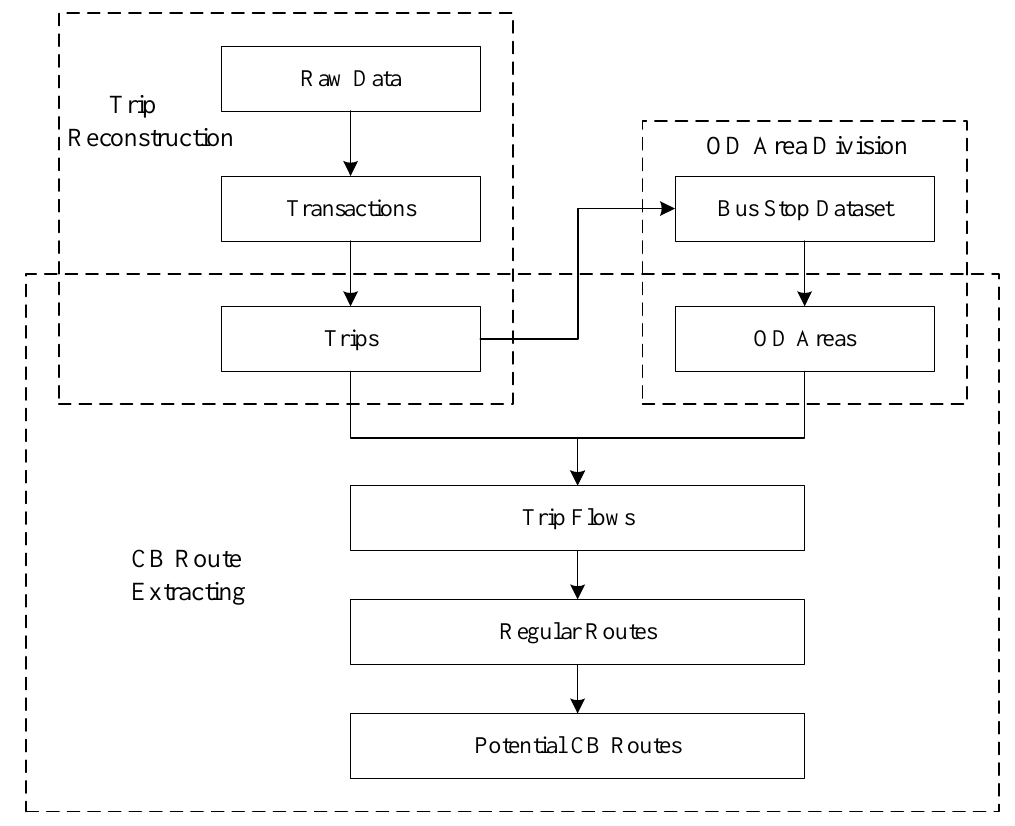
Figure 1. Flow chart of the framework.